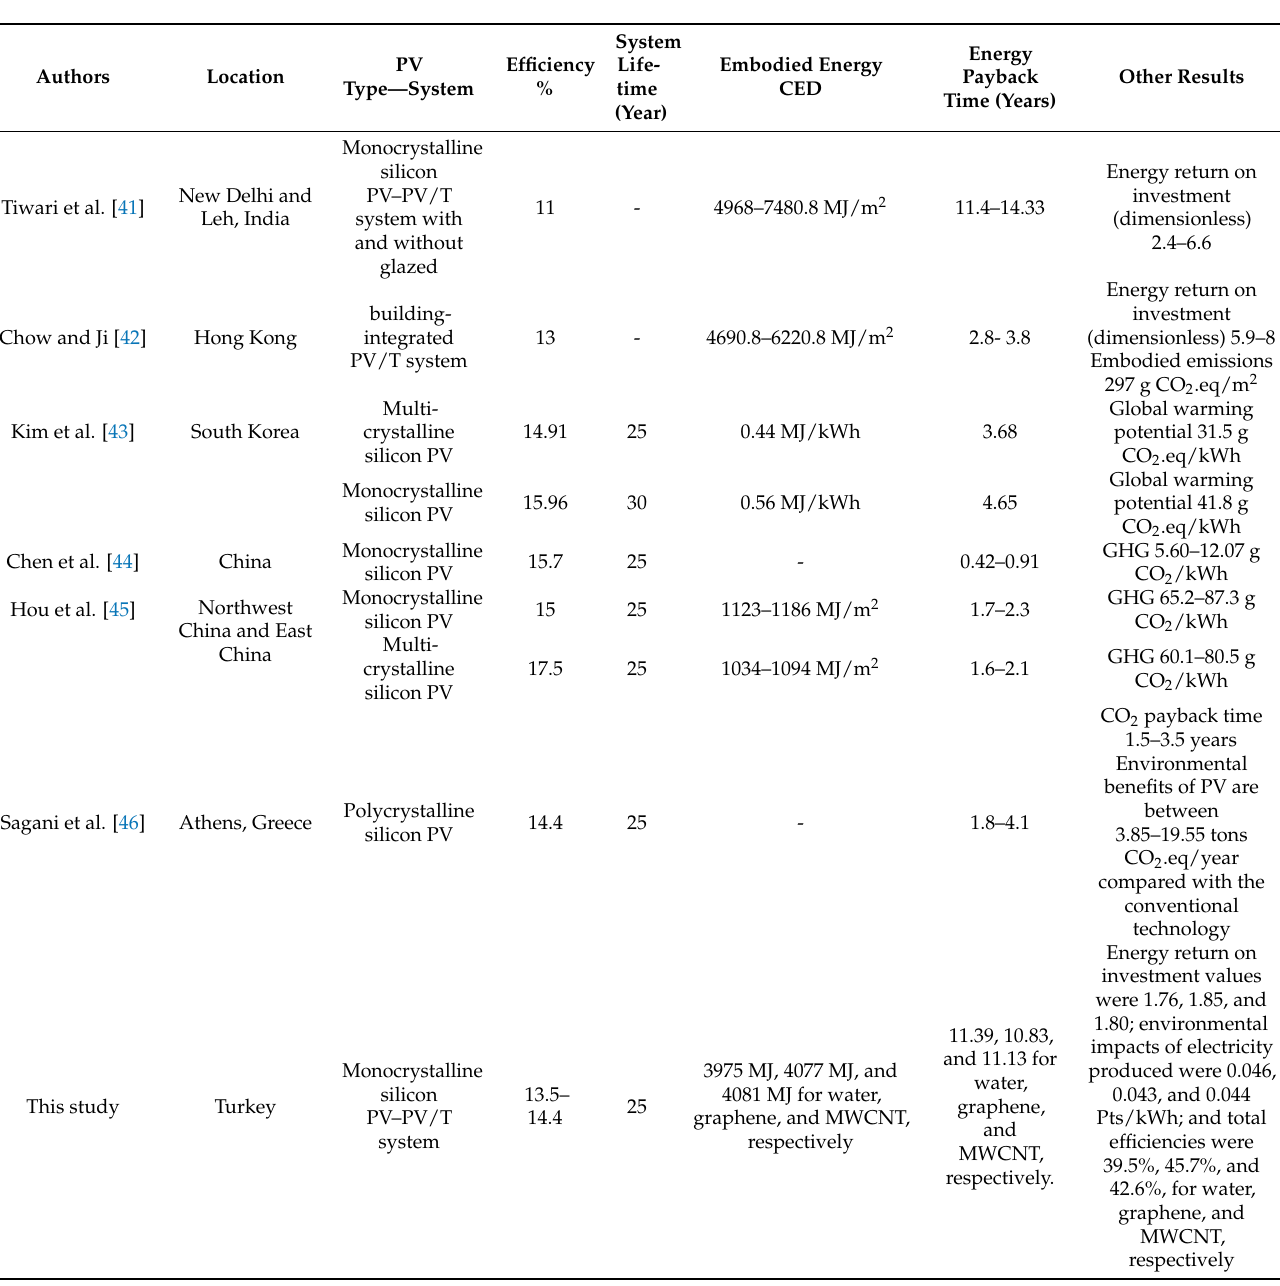
Table 5. A comparison of the LCA analysis results of the presented study with those of studies in the